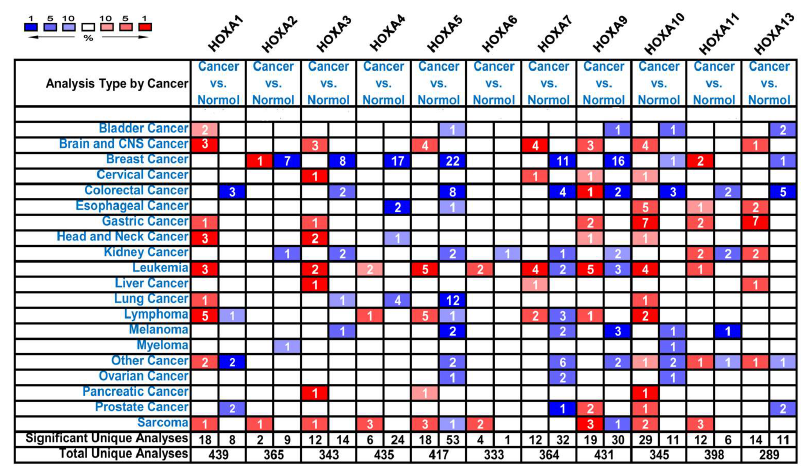
Figure 1. The transcription levels of HOXA genes in different types of cancers. Table 1. The significant changes in HOXA expression in transcription level between different types of leukemia and normal samples (ONCOMINE Database). Gene Types of leukemia vs. Normal Samples Fold Change P Value t -Test